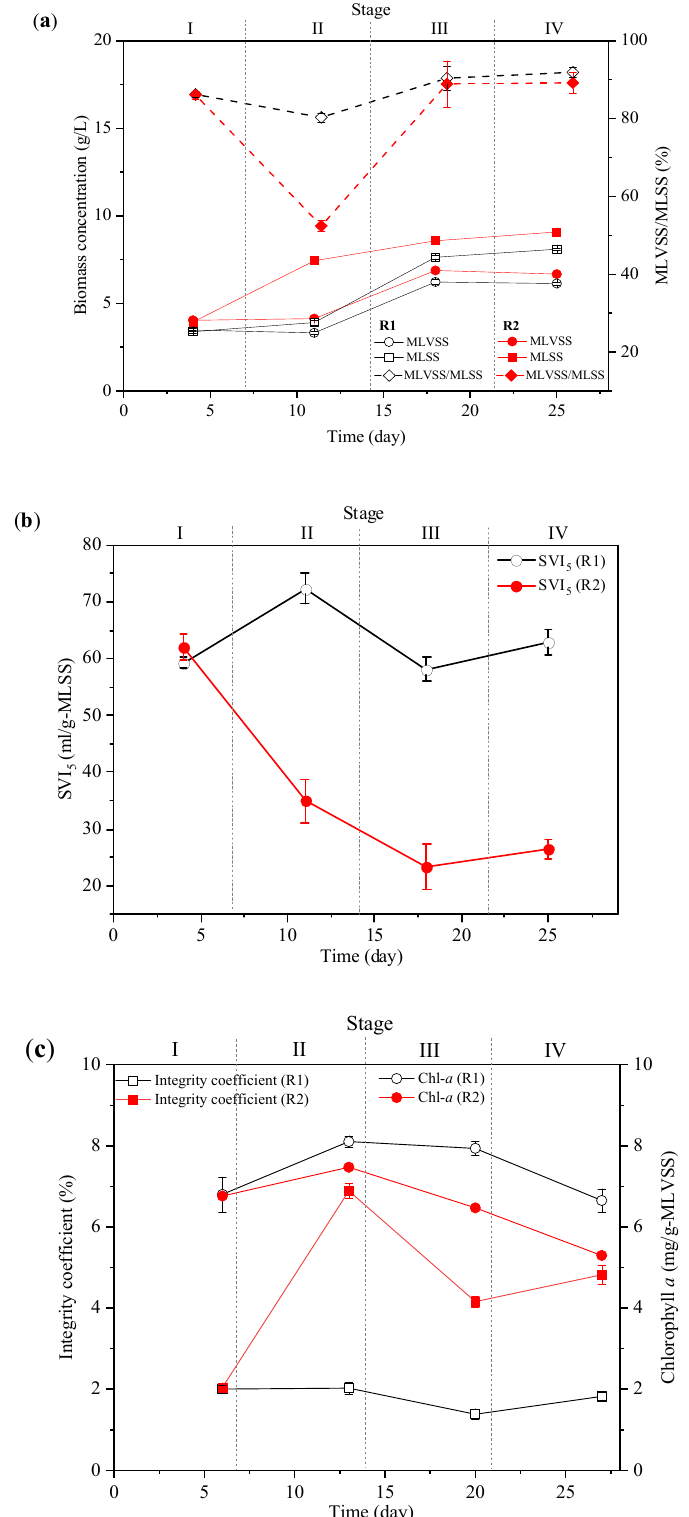
Figure 3. Characteristic changes of algal-bacterial AGS in R1 and R2 during the 28 days’ operation.